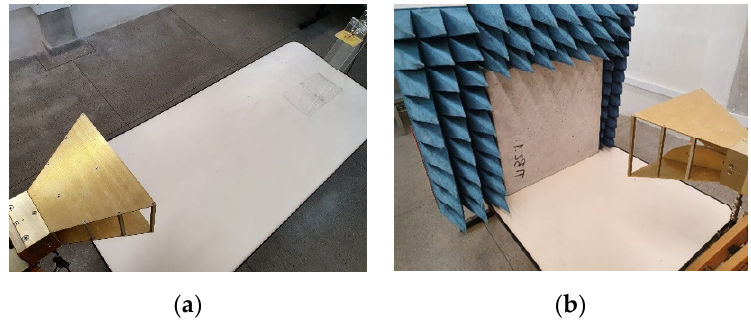
Figure 6. Photos of the measurement setup, showing the proposed antenna sensor, horn antenna, absorbers, and concrete block: ( a ) Setup without the MUT sample; ( b ) Setup with the MUT sample of concrete.